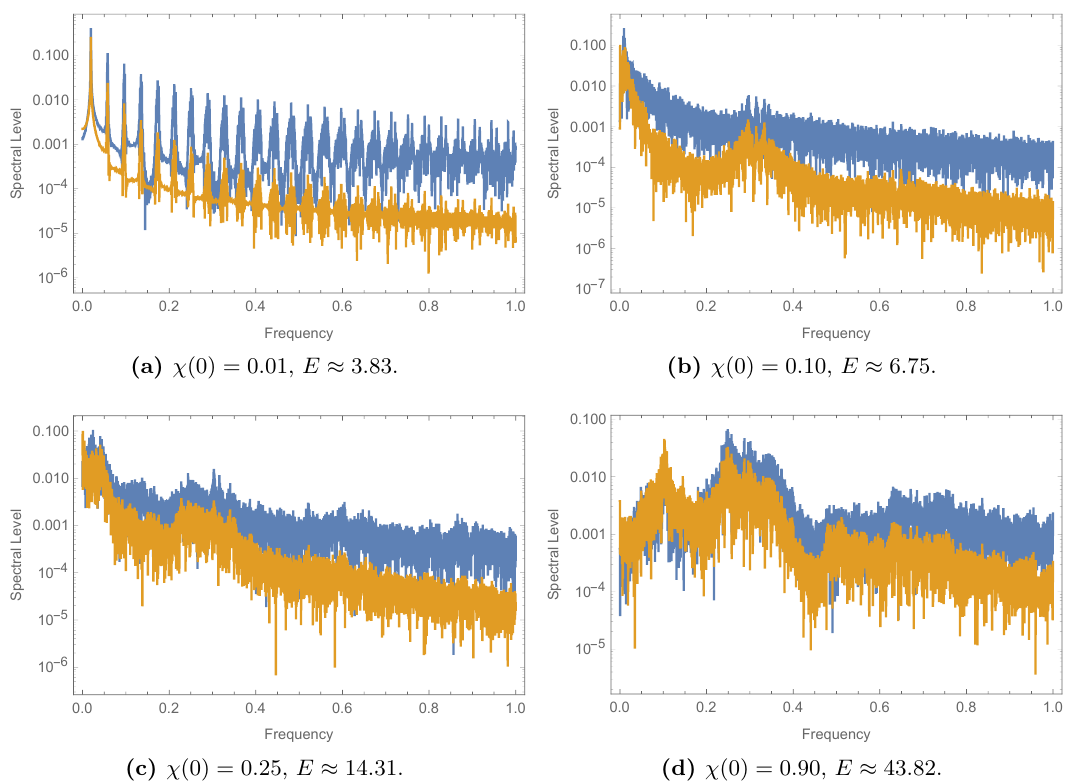
Figure 9. Power spectra for the trajectories in (cid:12)gures 8a{8d. Here the spectra for both z ( t ) and (cid:31) ( t ) are shown in yellow and blue respectively. To calculate these spectra we ran a numerical evolution up to t = 5000 (roughly 100 oscillations along the z -direction), with a resolution of 10 data-points per